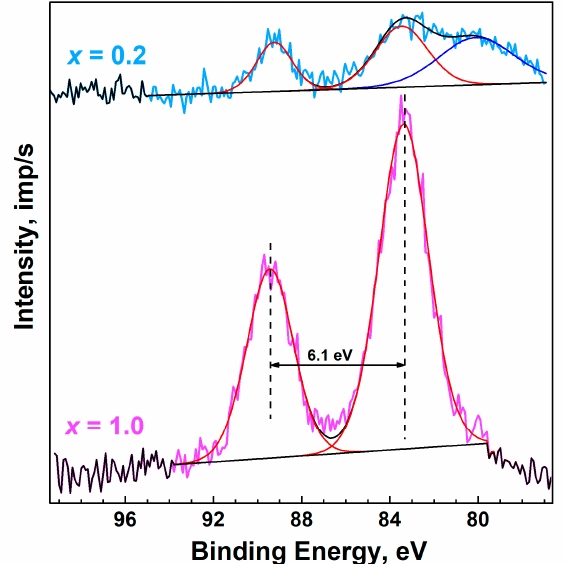
Figure 10. High-resolution XPS spectra of Mn3s peaks of Ca 9 − x Mn x Eu(PO 4 ) 7 x = 0.2 and 1.0. Table 3. Relative position of the satellite ( Δ Mn2p sat ) in Mn2p XPS spectra and splitting ( Δ Mn3s)